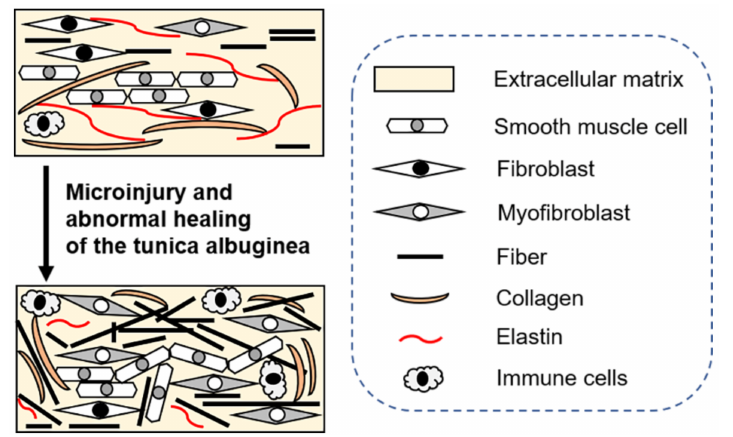
Figure 2. Schematic of the etiology and development of Peyronie’s